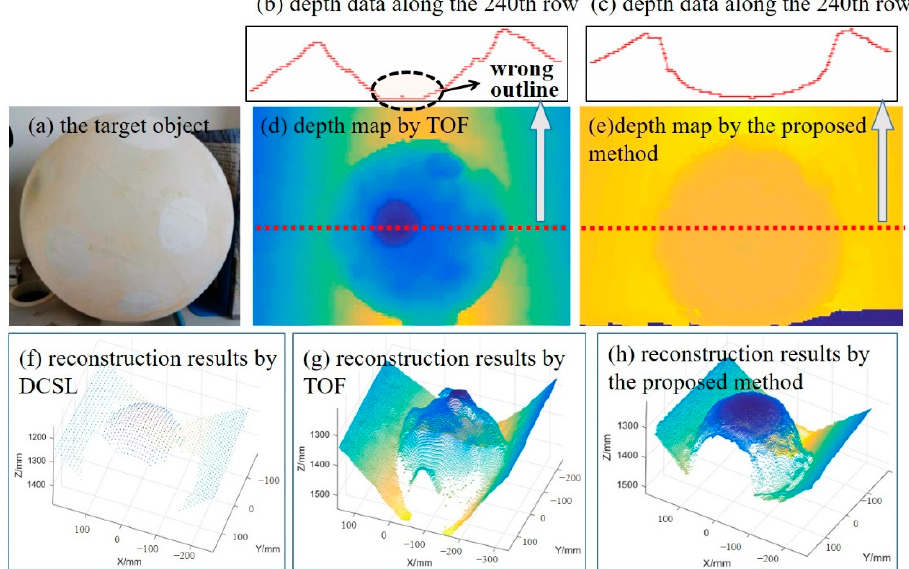
Figure 9. Reconstruction results of the spherical surface. ( a ) the target object; ( b ) estimated depth by TOF along the 240th row; ( c ) estimated depth by the proposed method along the 240th row; ( d ) estimated depth map by TOF; ( e ) estimated depth map by the proposed method; points clouds reconstructed by ( f ) DCSL; ( g ) TOF; and ( h ) the proposed method respectively.